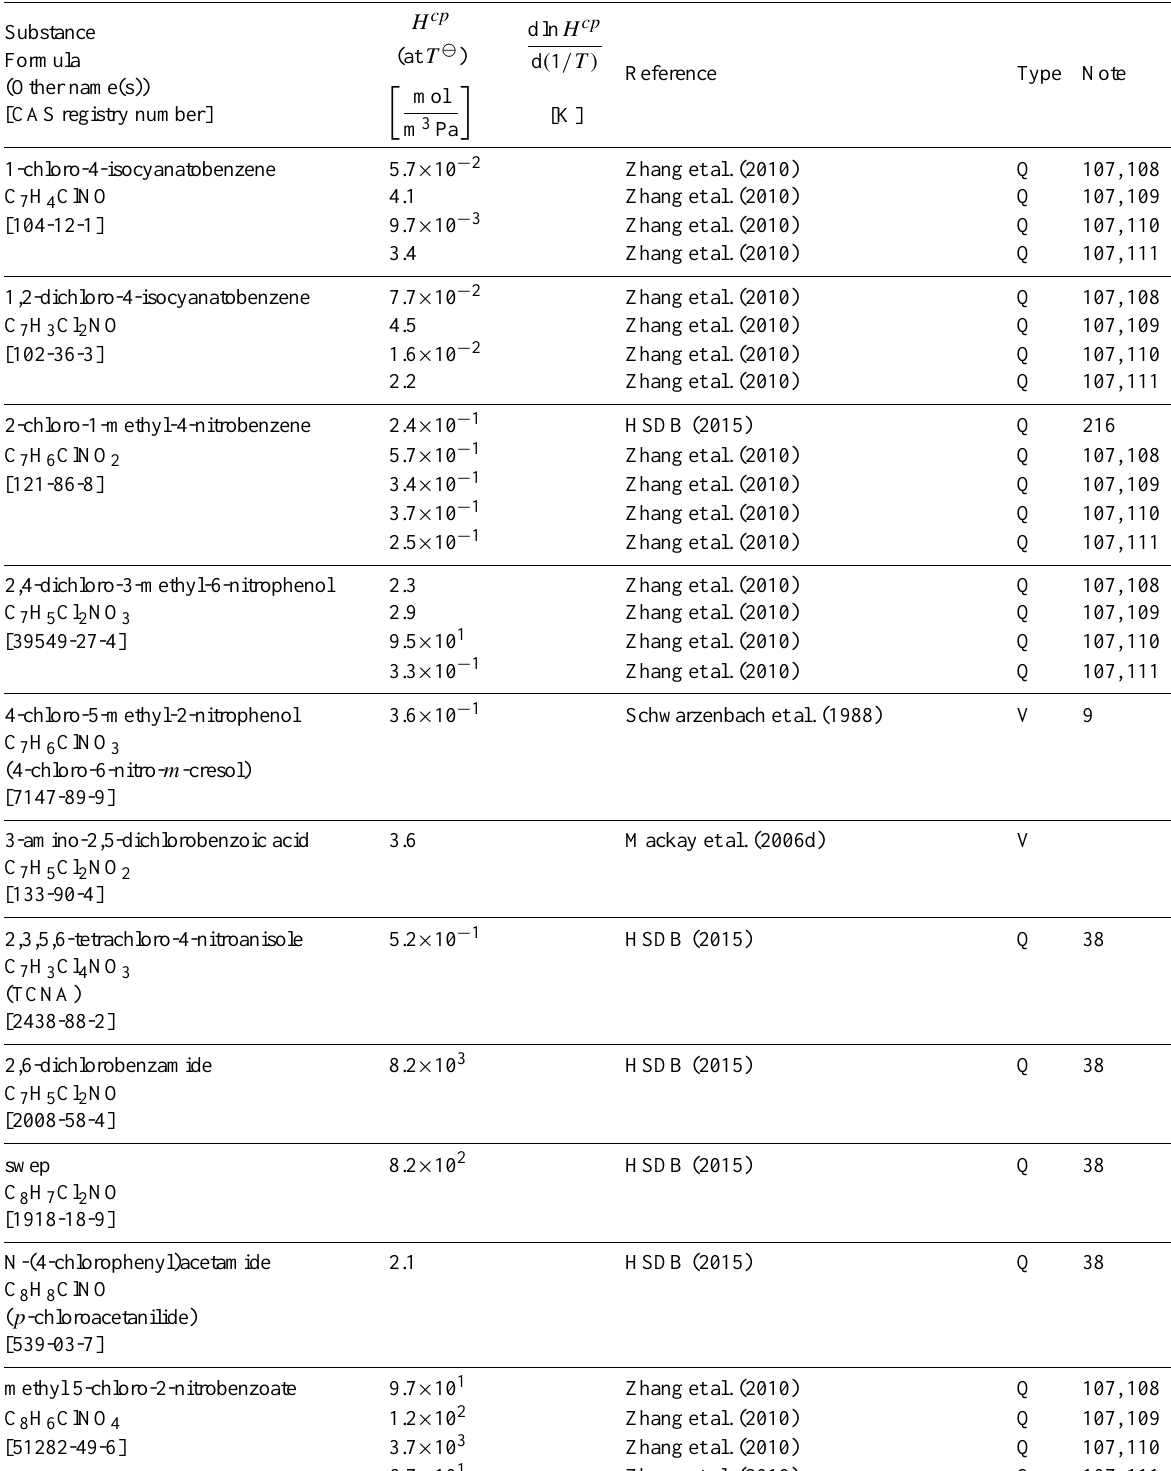
Table 6: Henry’s law constants for water as solvent